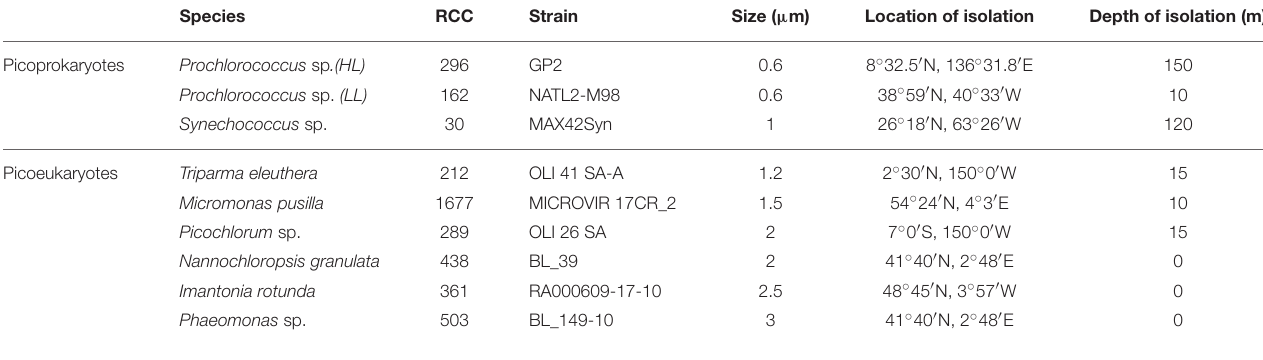
TABLE 1 | Picophytoplankton strains examined within this study, including three strains of picoprokaryotes and six strains of picoeukaryotes, their Roscoff culture collection number (RCC), stain, average cell size (diameter), and location and depth of isolation. Species